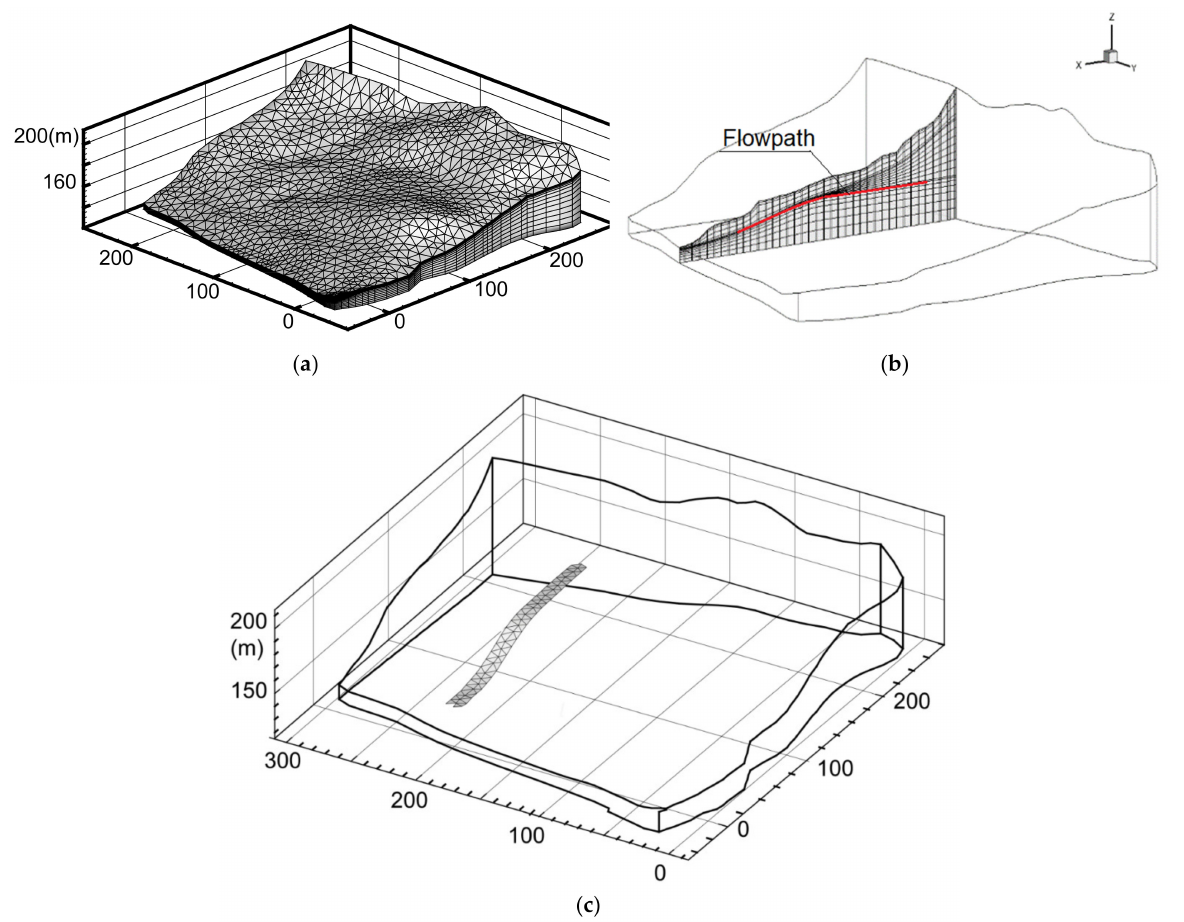
Figure 3. ( a ) The structure of the hydrogeological model, ( b ) the model’s sub layering, ( c ) morphology of the lateral